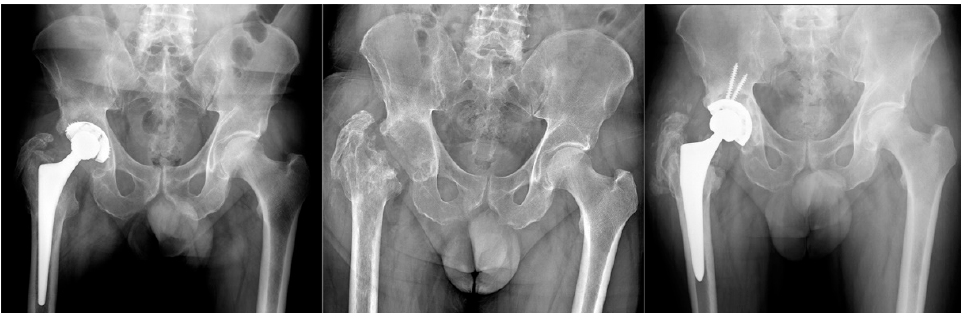
Figure 1. Group A Patient affected by chronic PJI treated with TSE. The patient was eligible for reimplantation after 4 month targeted antimicrobial therapy. After 12 months follow up there were no signs of recurrence of infection.